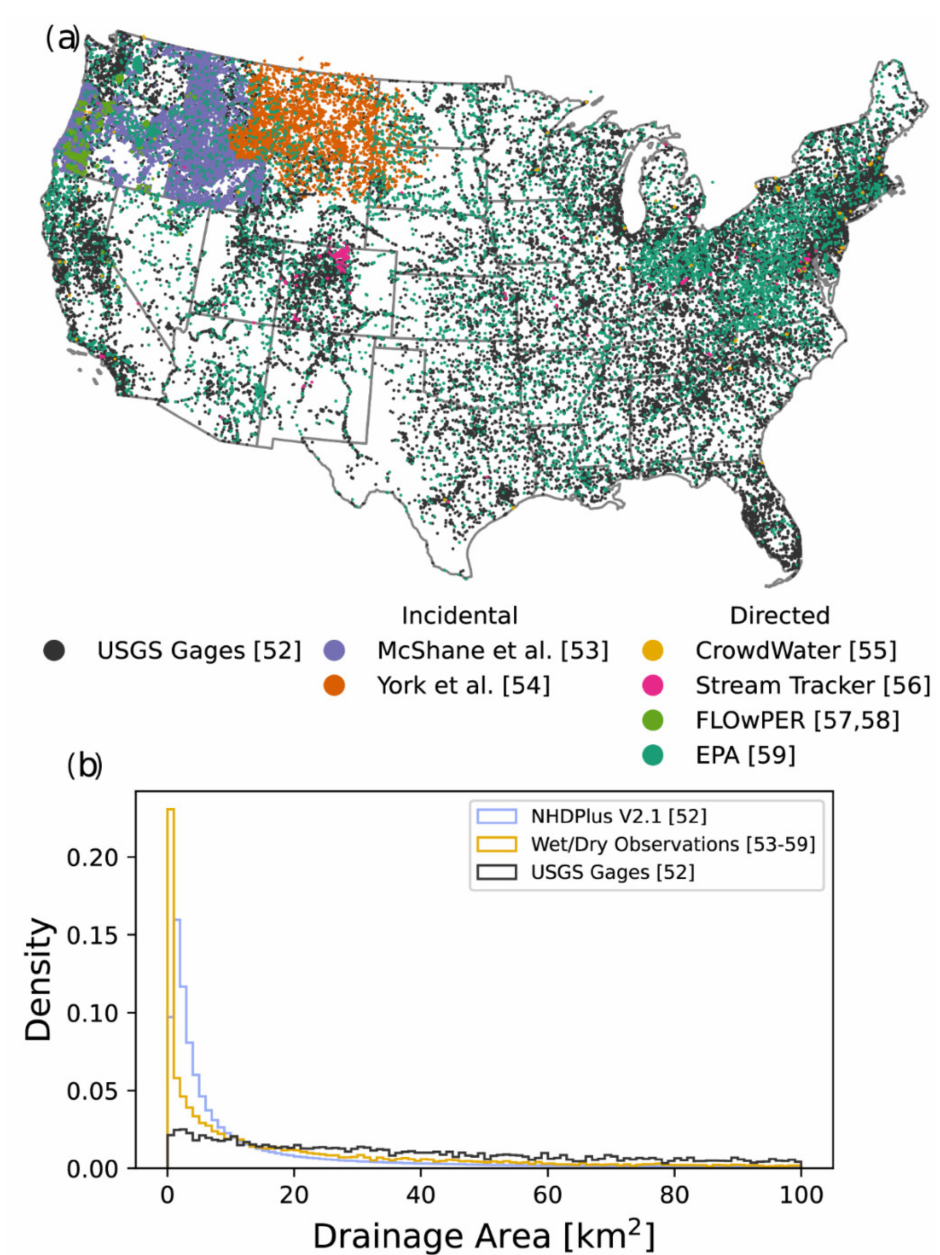
Figure 3. Map ( a ) of USGS NHDPlus V2.1 stream gaging network in CONUS [52] and wet/dry observations aggregated from stream survey incidental information [53,54], EPA probabilistic stream surveys, dedicated streamflow permanence surveys via mobile applications CrowdWater [55], Stream Tracker [56], and FLOwPER [57,58], and EPA probabilistic stream surveys (NRSA 2008–2009 and 2013–2014, WSA-Western EMAP 2000–2004, EMAP Mid-Atlantic Highlands Assessment 1993–1996, Mid-Atlantic Integrated Assessment 1997–1998, Kansas Regional EMAP 2001, and Eastern Cornbelt Regional EMAP 1995) [59], and density plots ( b ) of wet/dry observations, gages, and NHDPlus V2.1 flowlines in CONUS [52] drainage areas less than 100 km 2